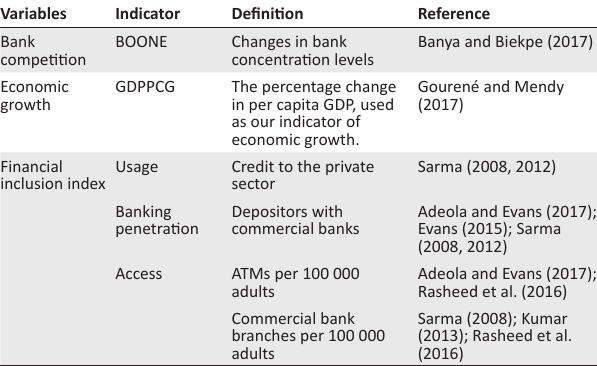
TABLE 1: Variable